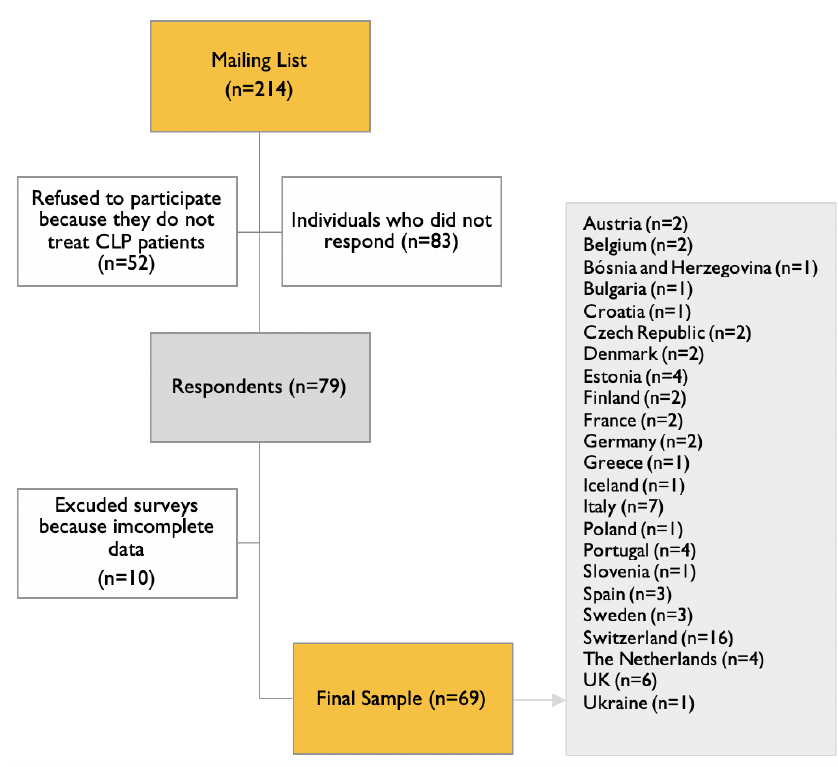
Figure 1. Flow chart of acquisition of final sample.